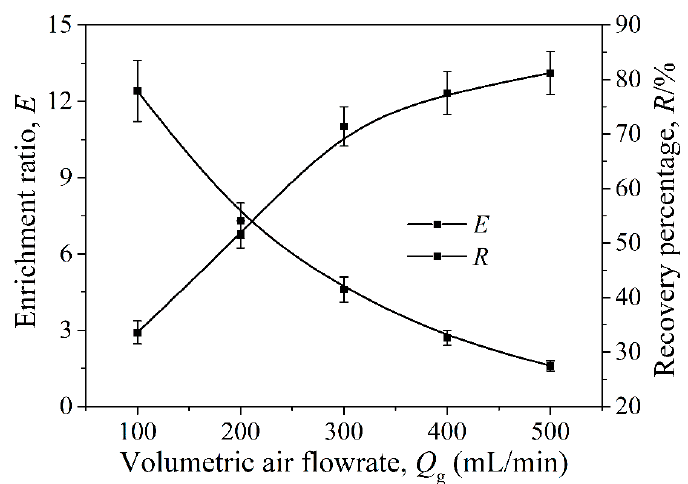
Figure 5. Effects of volumetric airflow rate on enrichment ratio and recovery percentage of total anthraquinones.